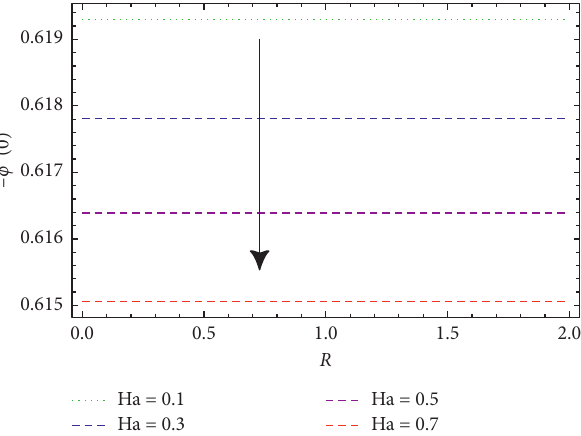
Figure 19: Sherwood number via R for changed values of